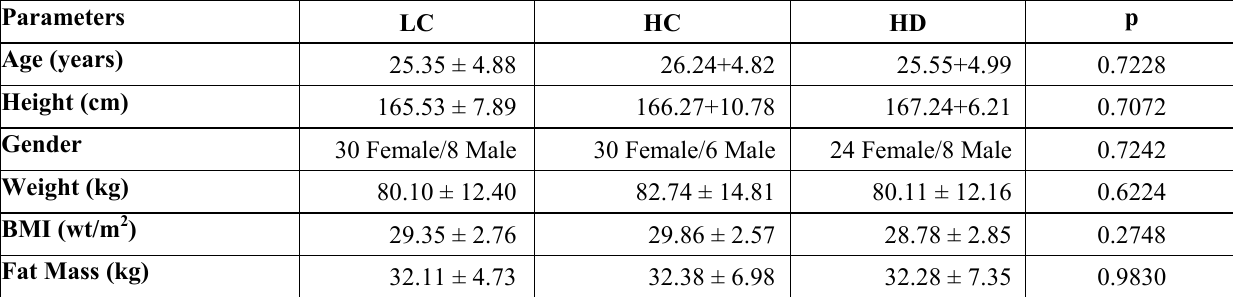
Table 2. Baseline Characteristics of Enrolled Subjects 1